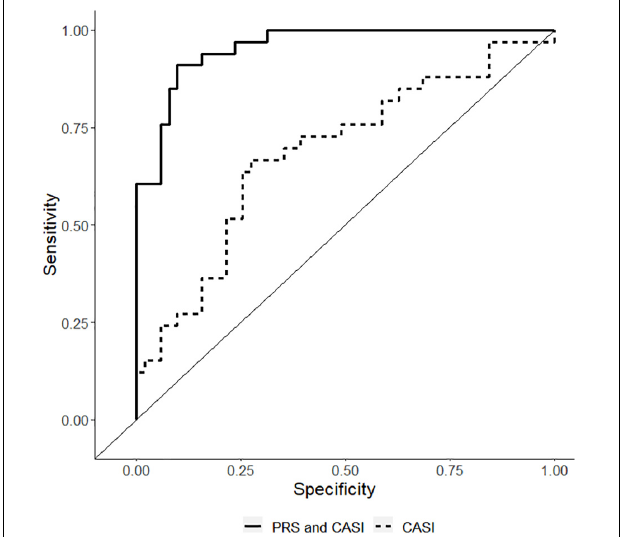
FIGURE 4 | Receiver operating characteristic curve showing the sensitivity/1-specificity for prediction of chronic post-surgical pain using the non-genetic model [including childhood anxiety sensitivity index (CASI) – dashed lines] compared with the prediction using the polygenic risk score final model (PRS and CASI – solid black lines). The area under curve for genetic model is 0.96 (95% CI: 0.92–0.99) compared to 0.70 (95% CI: 0.59–0.82) for non-genetic model ( p =